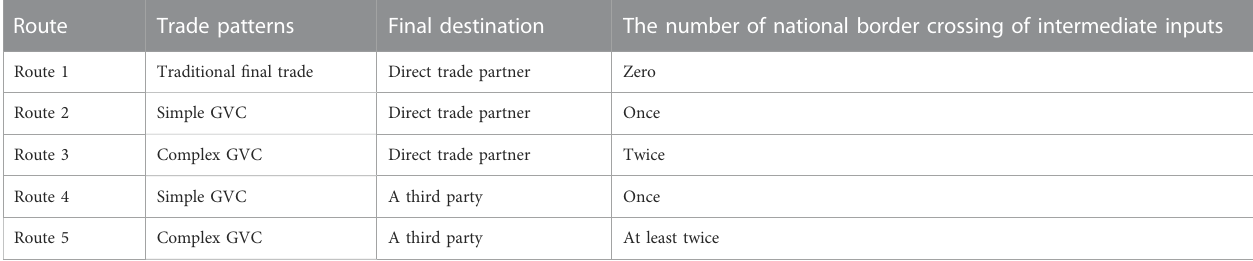
TABLE 1 De fi nition of fi ve value chain routes. Route Trade patterns Final destination The number of national border crossing of intermediate